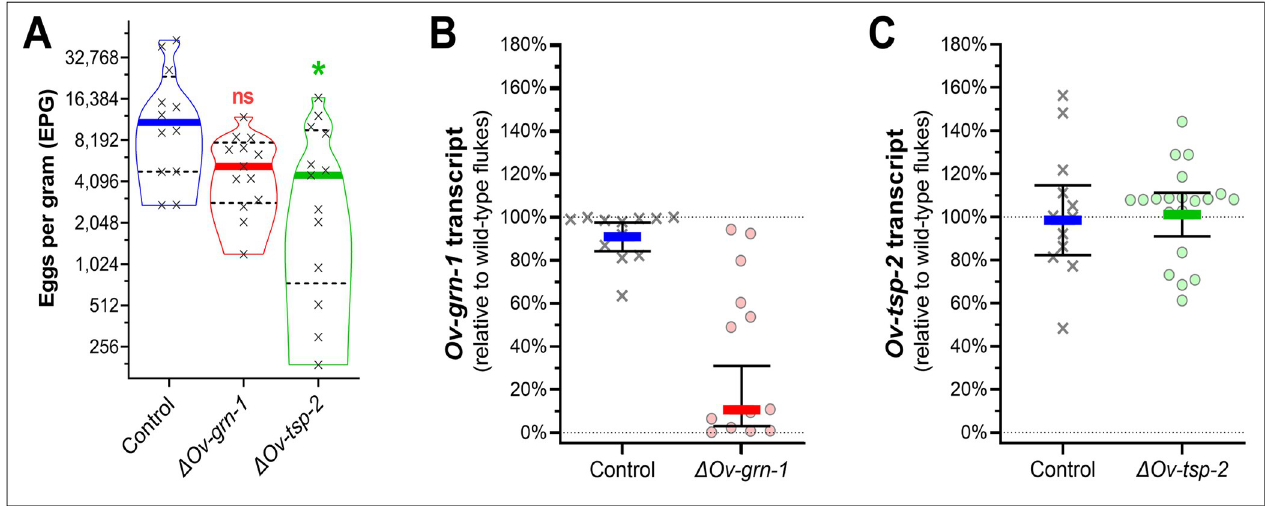
Fig 3. Cholangiocarcinoma model, fecundity, gene transcript and mutation rates. Eggs per gram of feces (EPG) were assessed at week 23 prior to euthanasia at week 24 (Experiment 2). Panel A , EPG values of the three groups of hamsters. Violin plot denotes each hamster’s EPG with “ x” symbols. Solid colored lines indicate the median values and dashed black lines indicate the quartiles. Kruskal Wallis with Dunn ’ s multiple comparison correction was used to compare EPG levels against control group: � , P � 0.05; ns, not significant. At necropsy, a sample of 12 to 20 flukes were collected from each group, transcript levels determined for Ov-grn-1 (B) and Ov-tsp-2 (C) , and plotted with each datum point representing the transcript level of the individual fluke relative to wild-type flukes. Resampling with replacement bootstrap analysis (B = 1000) of ddCT scores (derived from S4 Fig) was used to generate population average–denoted by the thick, colored line and 95% confidence interval